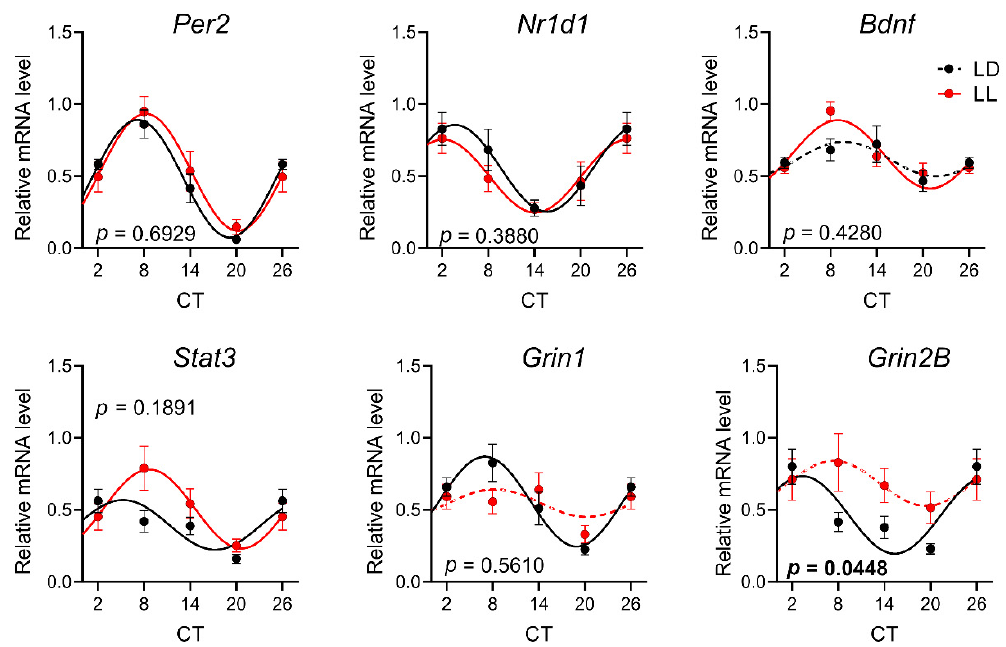
Figure 3. Effect of development under constant light (LL, in red; controls in LD in black) on rhythmic gene expression in SCN at P90. Animals were housed under LL (16 lux) from P0 until P20 and then released into LD conditions. At P90, the animals were sacrificed in 6 h intervals in DD, and SCNs were sampled by laser dissection and processed by qPCR with specific TaqMan probes. Rhythmicity was proved by cosinor analysis with a horizontal line as zero hypothesis and one-way ANOVA for differences between the time groups. Full lines indicate rhythms confirmed by cosinor analysis and one-way ANOVA. Dashed lines indicate profiles not confirmed for rhythmicity by one or both methods. Each point represents the mean ± SEM from five to seven animals. p -values indicate group difference by two-way ANOVA, and significant values are in bold.